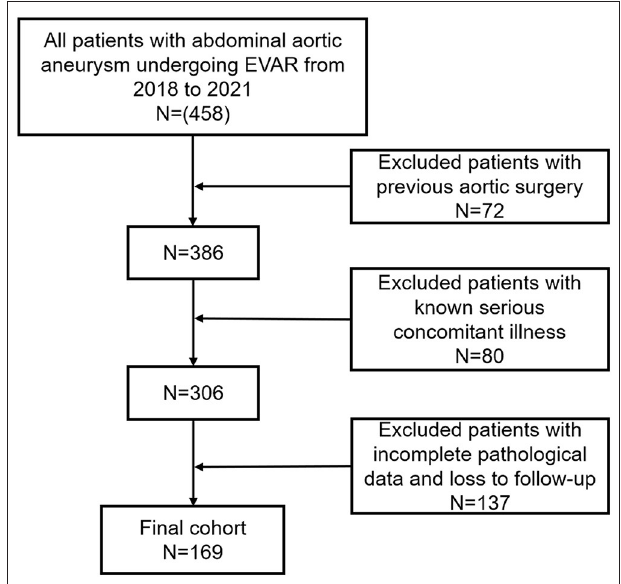
FIGURE 1 | Diagram of study